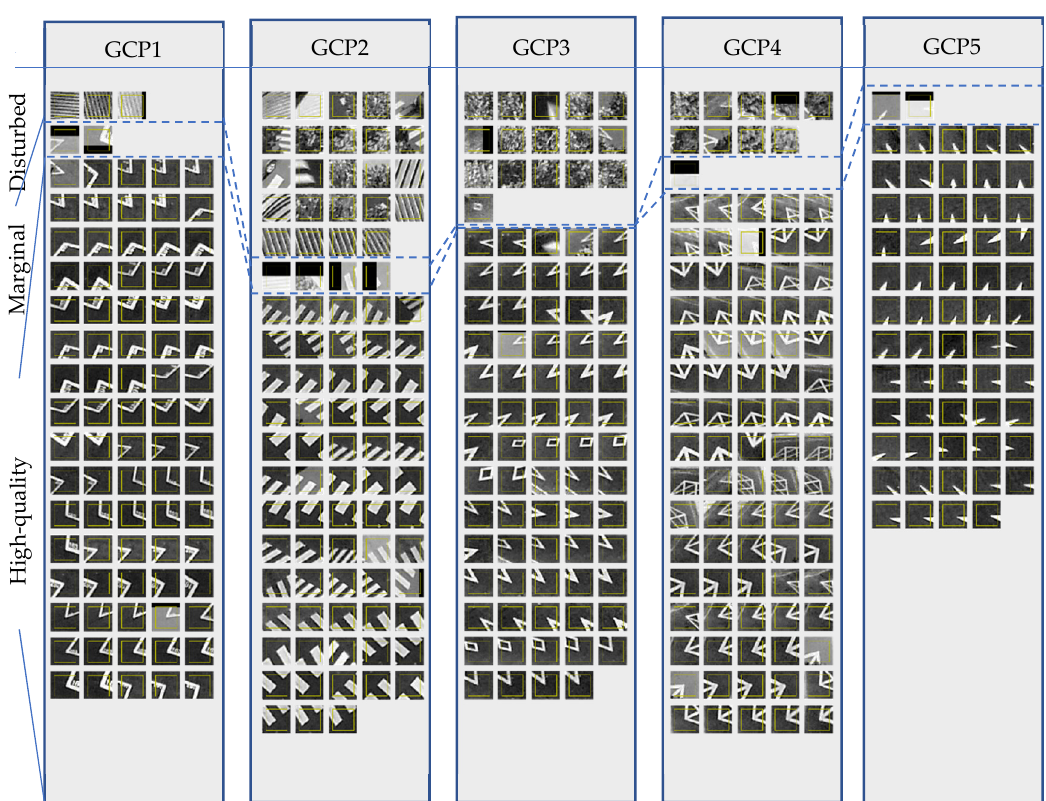
Figure 6. The quality classification of ROIs for the five GCPs: the high-quality, the marginal, and the disturbed.